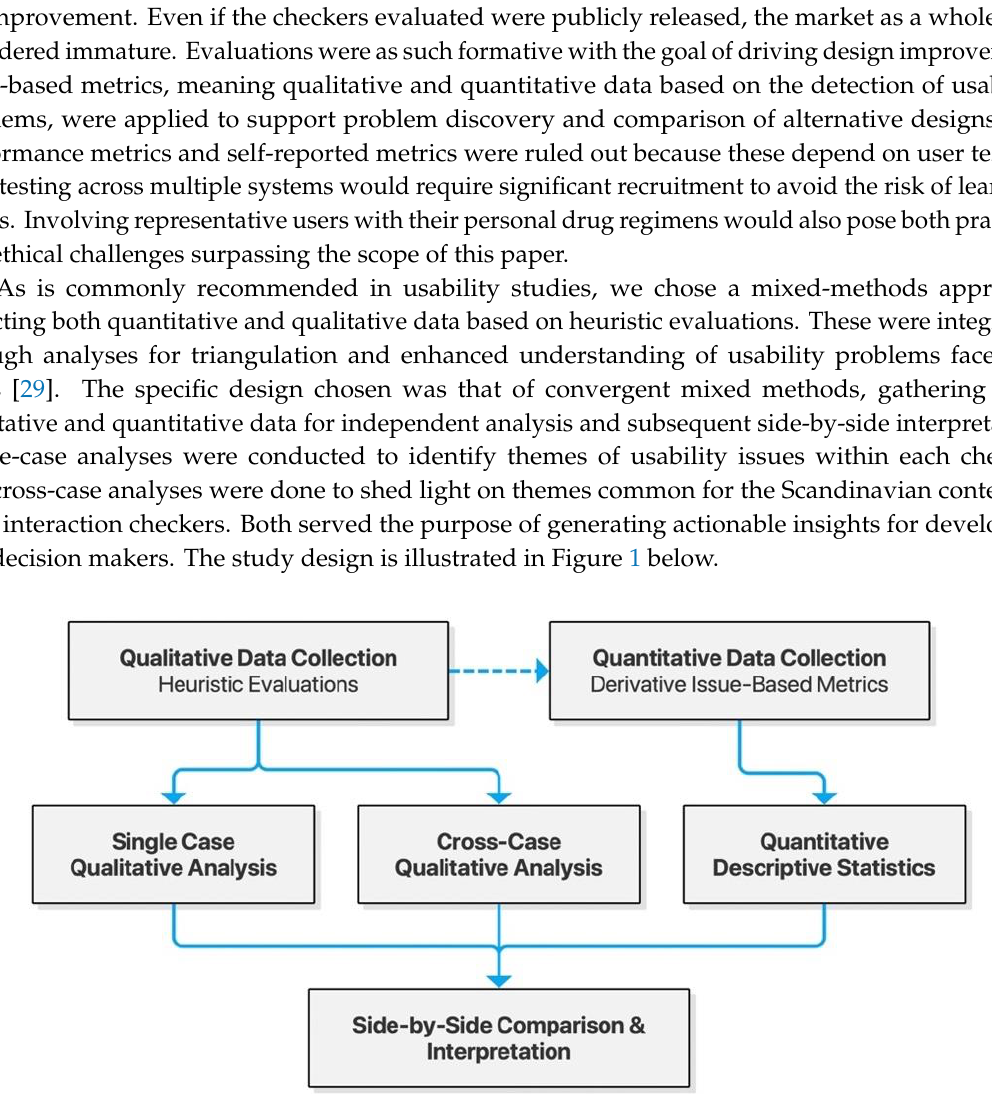
Figure 1. Model of the convergent mixed-methods study design.